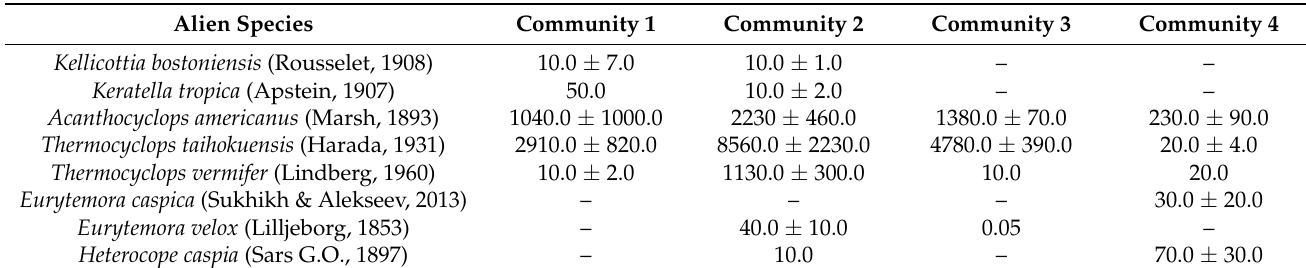
Table 2. Average (mean ± SD) density (ind./m 3 ) of alien zooplankton species in the studied water bodies, categorized according to the identified zooplankton communities.